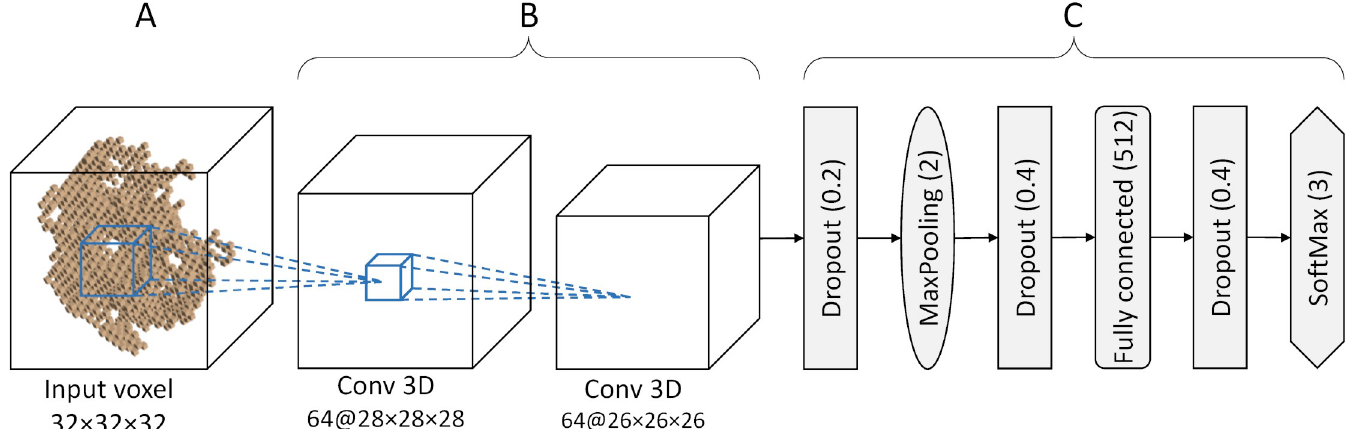
Fig 2. Structure of a convolutional neural network in DeepDrug3D. The network consists of ( A ) an input voxel followed by ( B ) two convolutional layers with leaky ReLu activation functions, and ( C ) a series of dropout, pooling, fully connected and softmax layers.